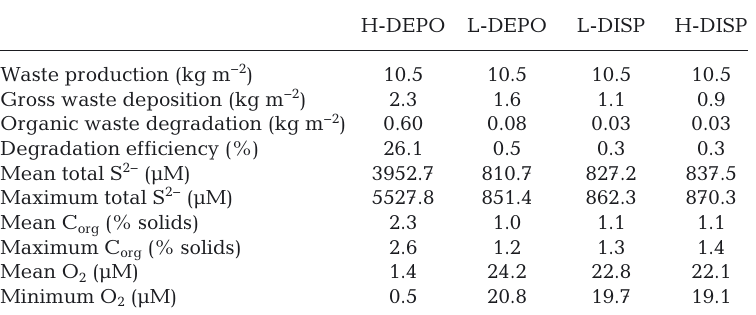
Table 4. Benthic processes at fish farm sediments under 4 hydrodynamic scenar- ios: high and low deposition (H- and L-DEPO) and low and high dispersion (L- and H-DISP). Simulations were carried out assuming a representative fish farm pro- duction cycle according to Table 1, including a feed wastage of 3%, twice-per-day feeding (for 20 min each), and a constant water depth of 20 m below the fish cage (35 m in total). Wastage rate including feces and lost feed was equal to 19.4 g C org m −2 d −1 . Degradation efficiency was calculated based on daily averaged C org degradation and gross deposition rates. Gross C org deposition rates represent the flux that reaches sediments prior resuspension, but after dispersion in the water column. The surface concentrations of C org , O 2 , and total S 2− are reported for the upper 2 cm of sediments. Mean values were calculated considering the entire